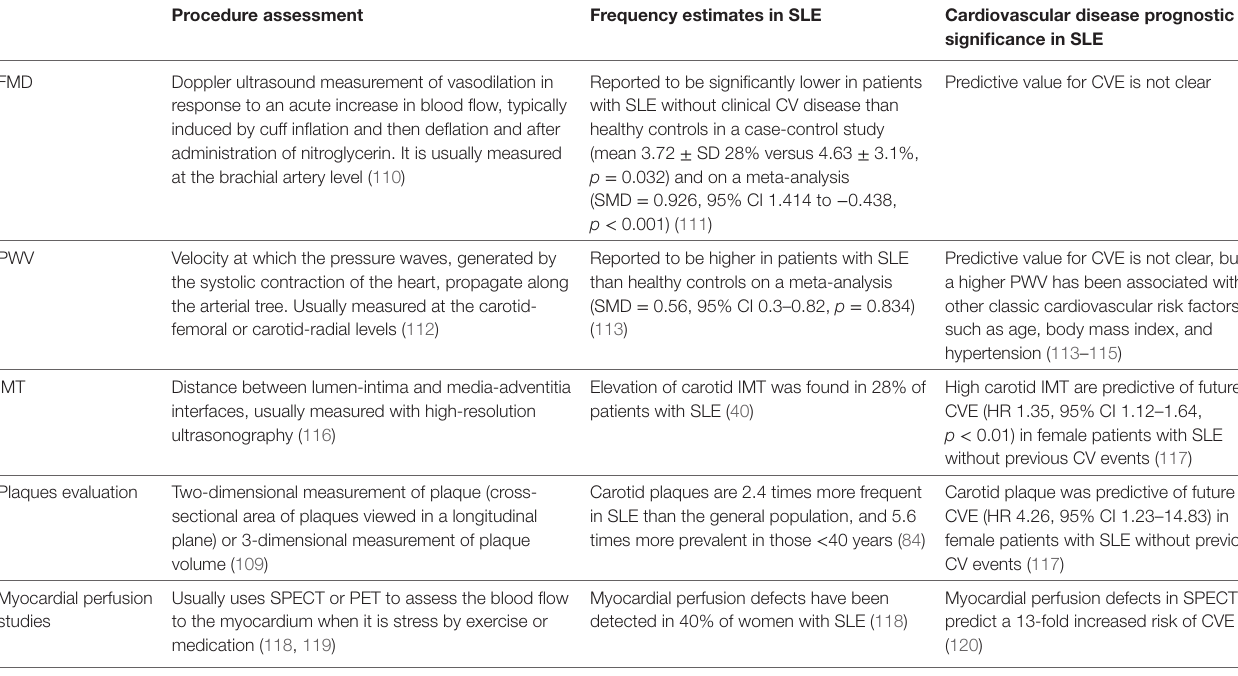
TABLe 2 | Summary of atherosclerosis imaging surrogates in